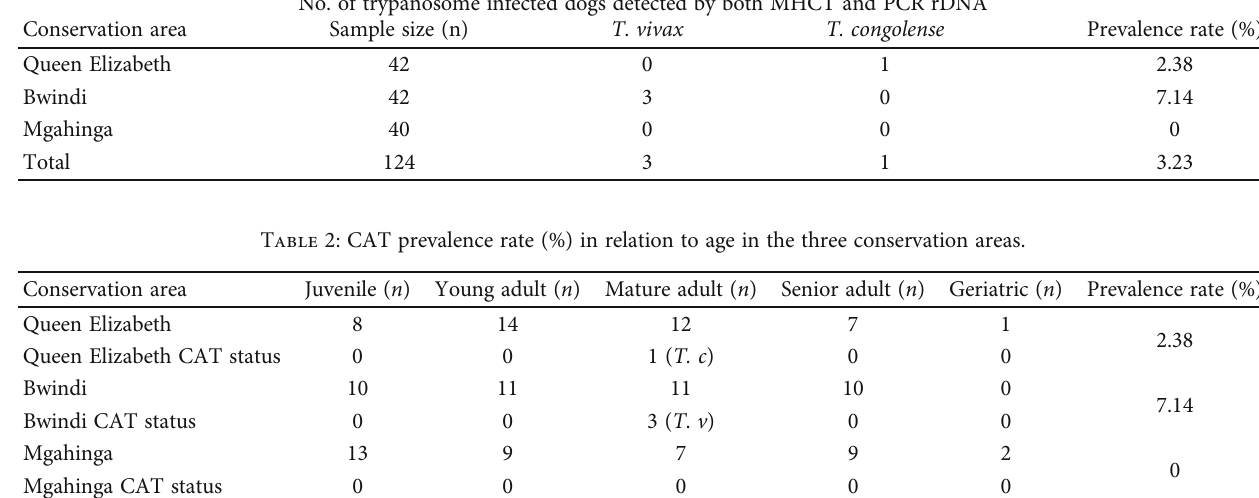
Table 1: Summary showing the total number of dogs examined and their infection status in the three conservation areas. No. of trypanosome infected dogs detected by both MHCT and PCR